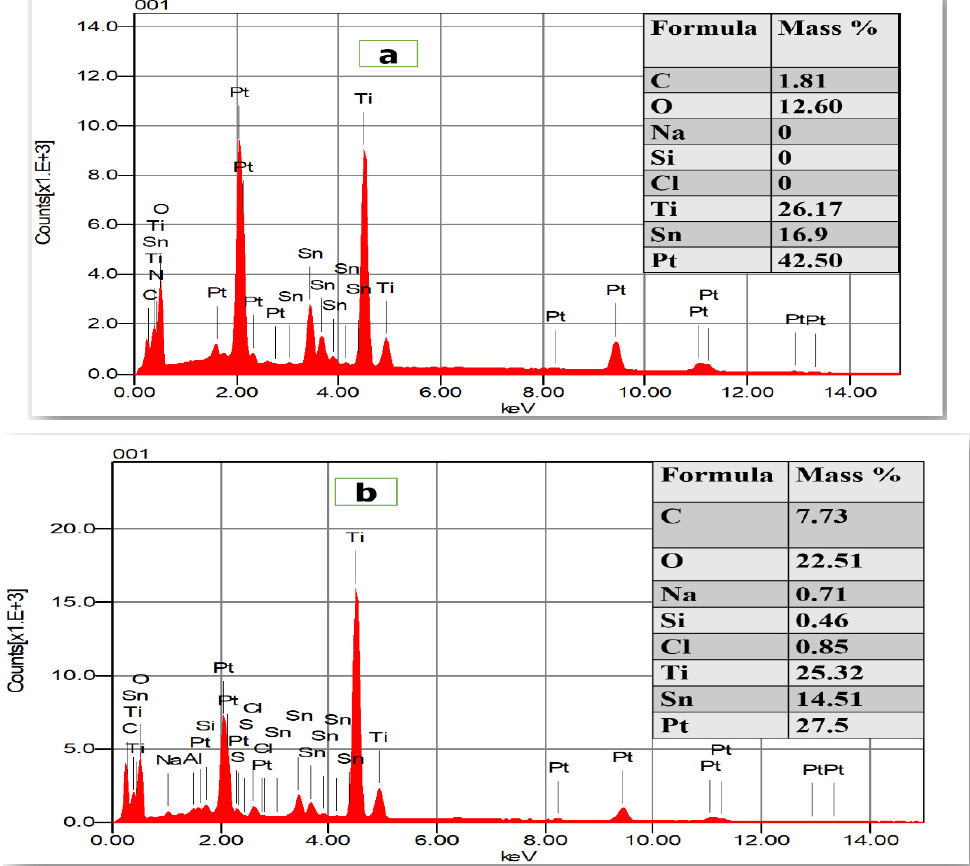
Figure 12. EDX analysis of the electrode surface before and after use: ( a ) Ti/Pt/SnO 2 surface before use, ( b ) Ti/Pt/SnO 2 surface after use.